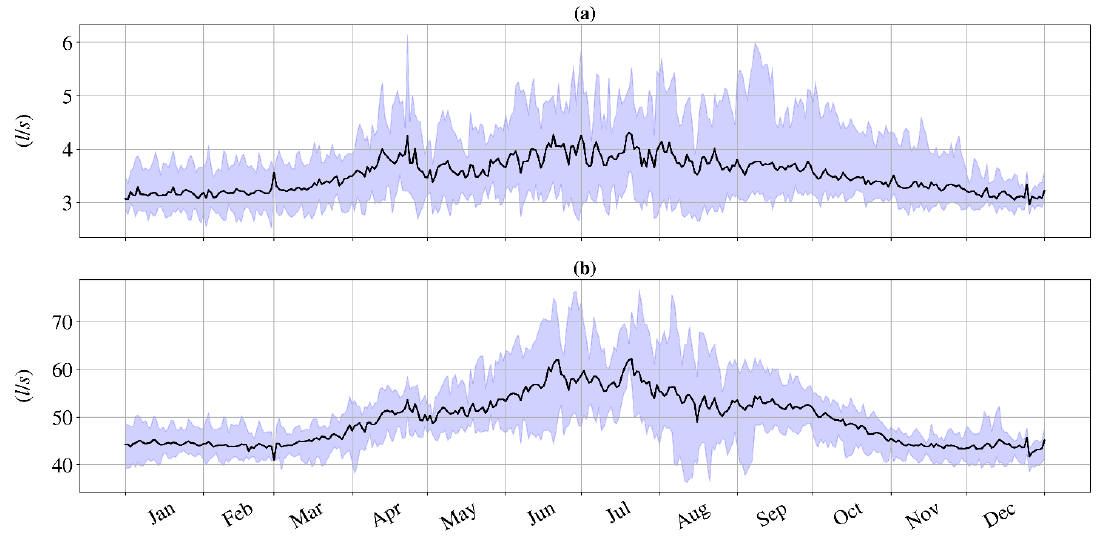
Figure 1. ( a ) Daily average water demand for case study 1 from 2013 to 2020, ( b ) Daily average water demand for case study 2 from 2013 to 2019. Black line depicts the daily average value, whereas the purple interval shows the minimum and maximum value for each day.